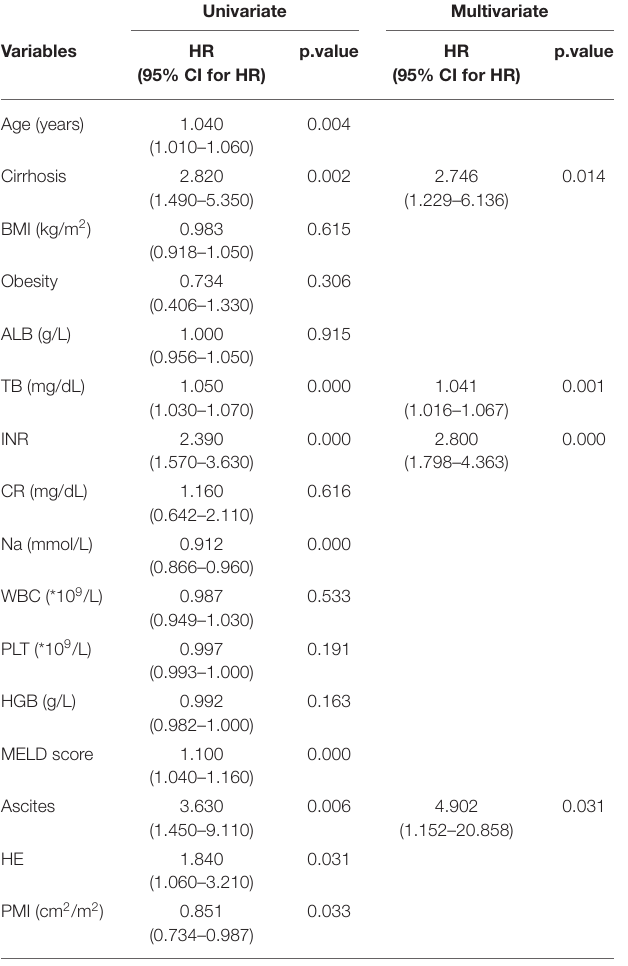
The multivariate logistic regression model was fited with a stepwise selection method using statistically baseline factors that had been screened in univariate analysis. BMI, bodymassindex;ALB,albumin;TB,totalbilirubin;INR,Internationalnormalizedratio;CR, Serum creatinine; Na, Serum sodium; WBC, White blood cell count; PLT, platelet; HGB, hemoglobin;MELD,modelforend-stageliverdisease;HE,Hepaticencephalopathy;PMI, psoas muscle index.